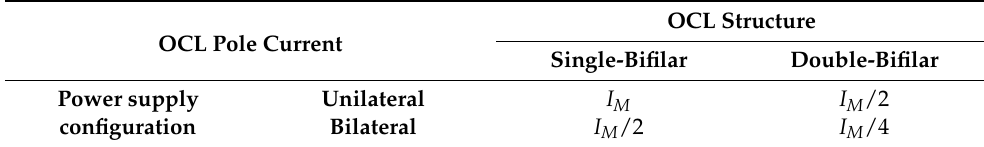
Table 1. OCL pole current for overload